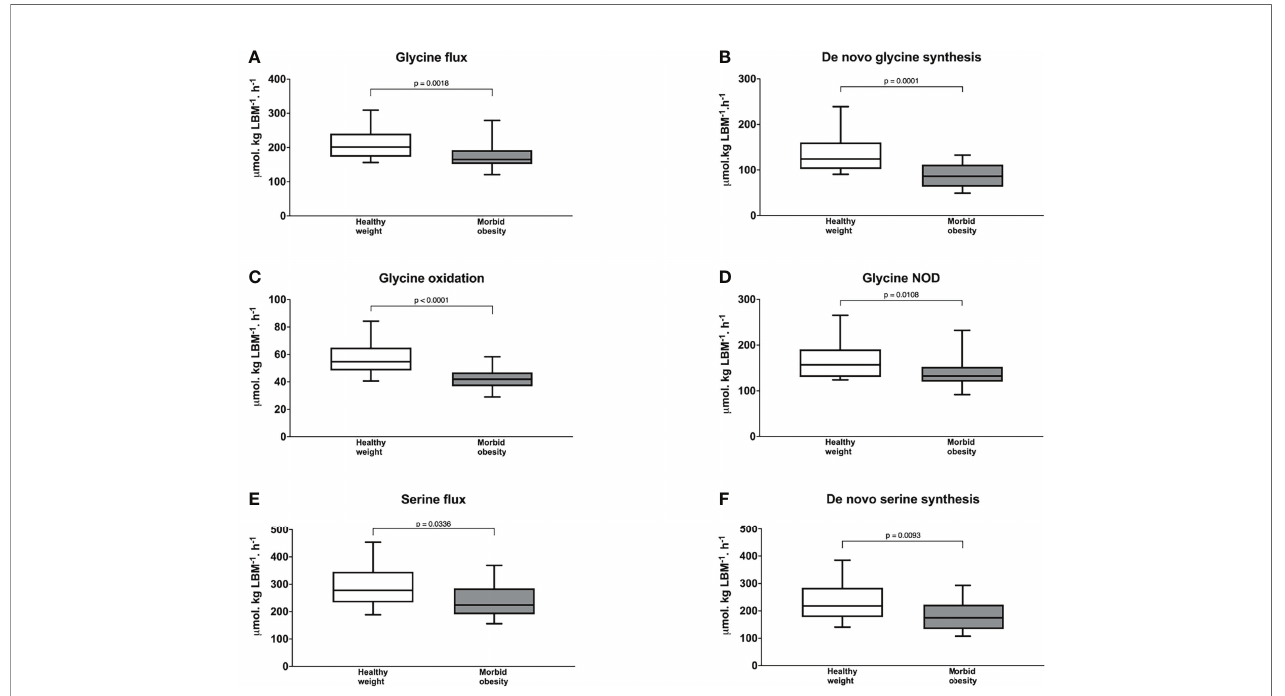
FIGURE 2 | Glycine fl ux (A) de novo glycine synthesis (B) glycine oxidation (C) and glycine non-oxidative disposal (D) serine fl ux (E) ; and de novo serine synthesis (F) in participants with healthy weight (n = 21) and with morbid obesity at baseline (n = 21). The Mann – Whitney U test was used to test the statistical differences between participants with healthy weight and participants with morbid obesity. NOD = non-oxidative disposal. P value < 0.025 is considered as statistically signi fi